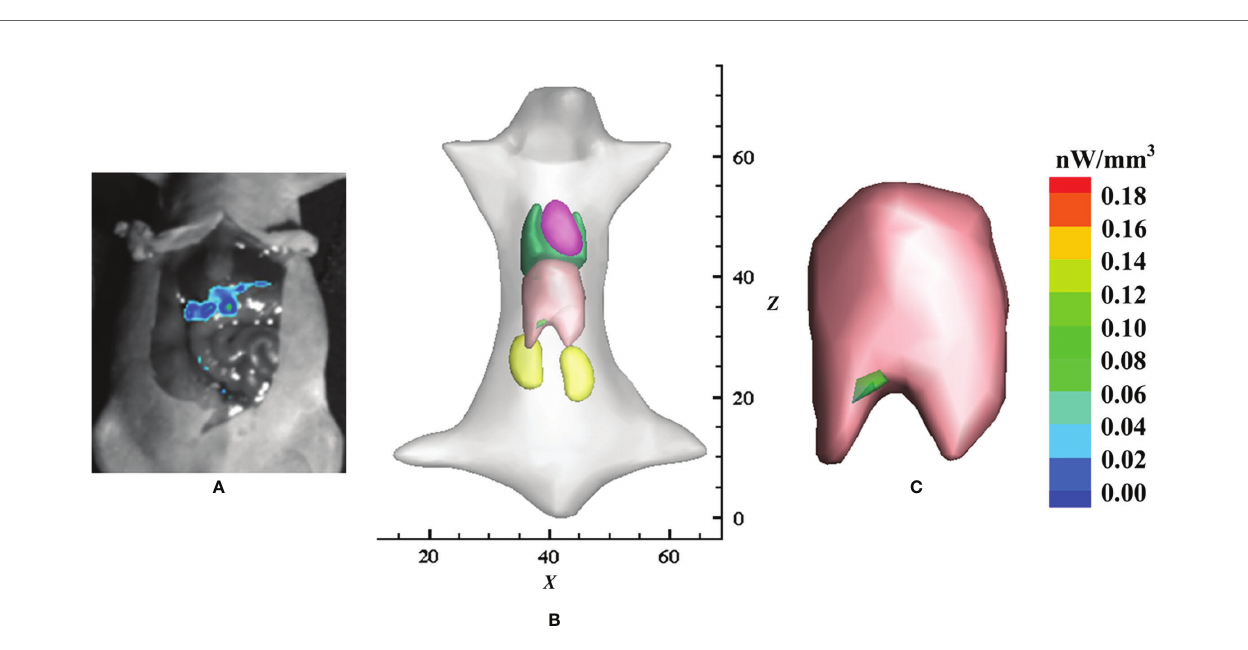
FIGURE 3 | Application of the HSDE model in the detection of in situ liver cancer. (A) Laparotomy results with the liver exposed and imaged using bioluminescence imaging, (B) reconstructed result by the HSDE-based fl uorescence tomography, and (C) relevant local enlarged image. Adapted with permission from